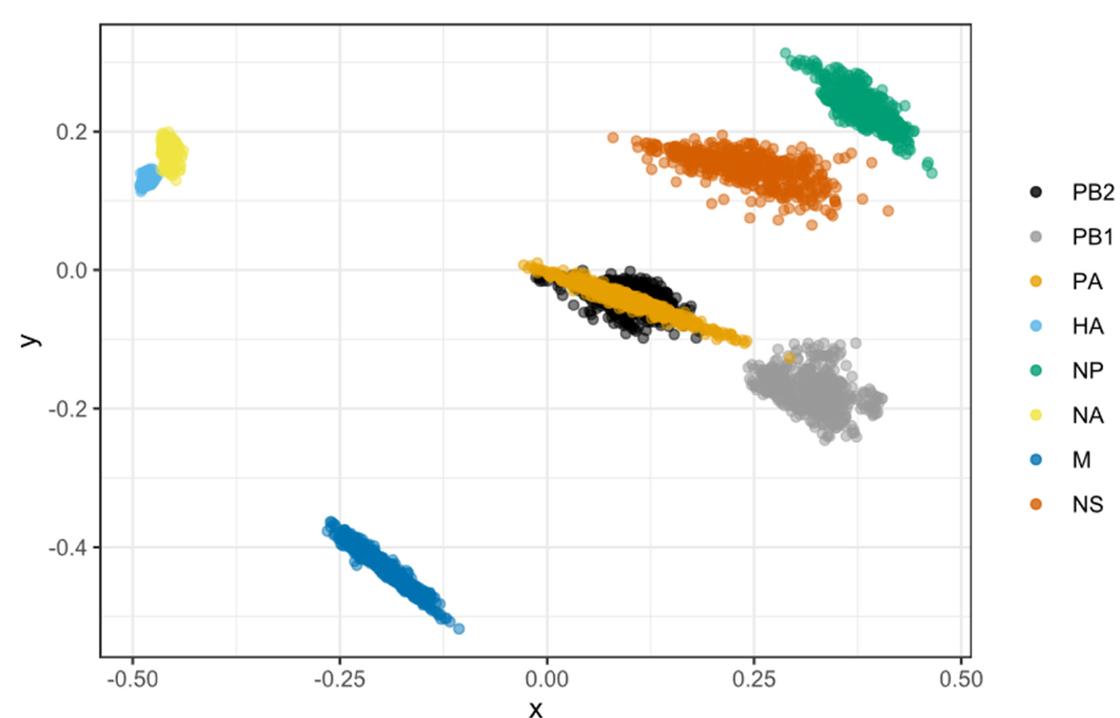
Figure 8. Correlations in time to the most recent common ancestor (tMRCA) among H7N9 viral segments as depicted by a multidimensional scaling (MDS) graphic. MDS enables a two-dimensional representation of the total level of cross-correlation between all segments. Cloud points represent phylogenetic uncertainty based on 500 trees for each segment sampled in the program of BEAST, with pairwise comparisons to other segments limited to viruses sampled in the same year. In the absence of reassortment, segments are likely to have highly correlated TMRCAs due to shared evolutionary history showing as overlapping dots. Reversely, segments split up by reassortment are predicted to inhabit various plot regions. Only the first two scaling dimensions are visible.